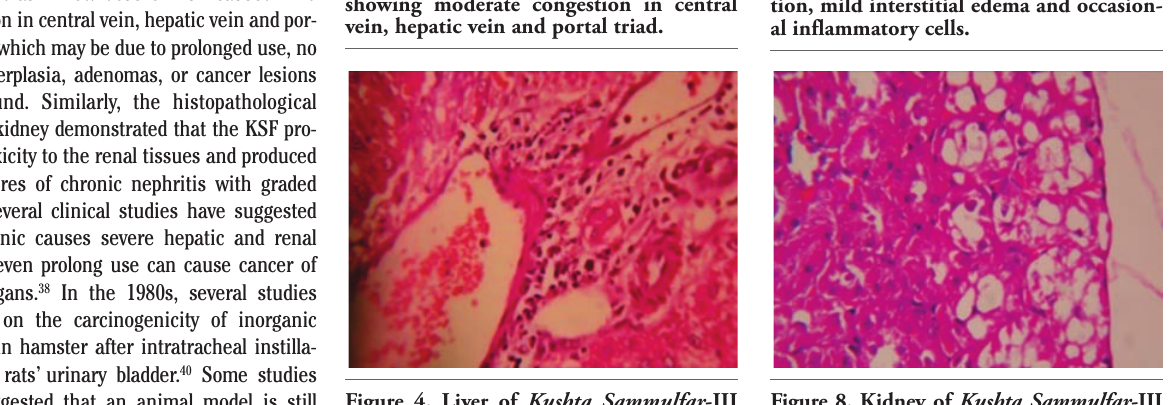
Figure 8. Kidney of Kushta Sammulfar -III showing inflammatory cells, glomerular congestion, severe vascular congestion, mild interstitial edema and inflammatory